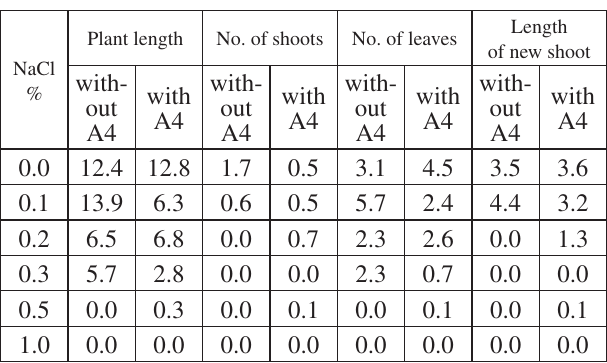
Table 1: Characteristics of giant reed plants inoculated by bacterium